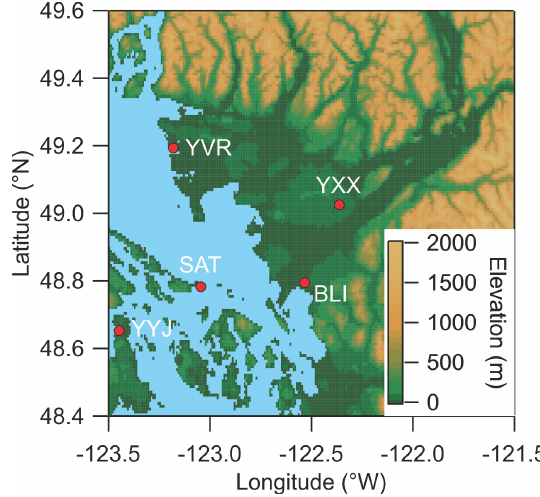
Figure 1. Map of the Lower Fraser Valley. YXX is the Abbotsford International Airport (measurement location for this study). YVR is the Vancouver International Airport. YYJ is the Victoria Interna- tional Airport. BLI is the Bellingham International Airport. SAT is Saturna